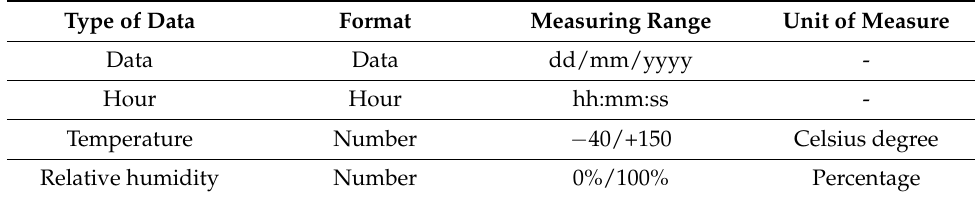
Table 3. Data collected by the multi-parameter